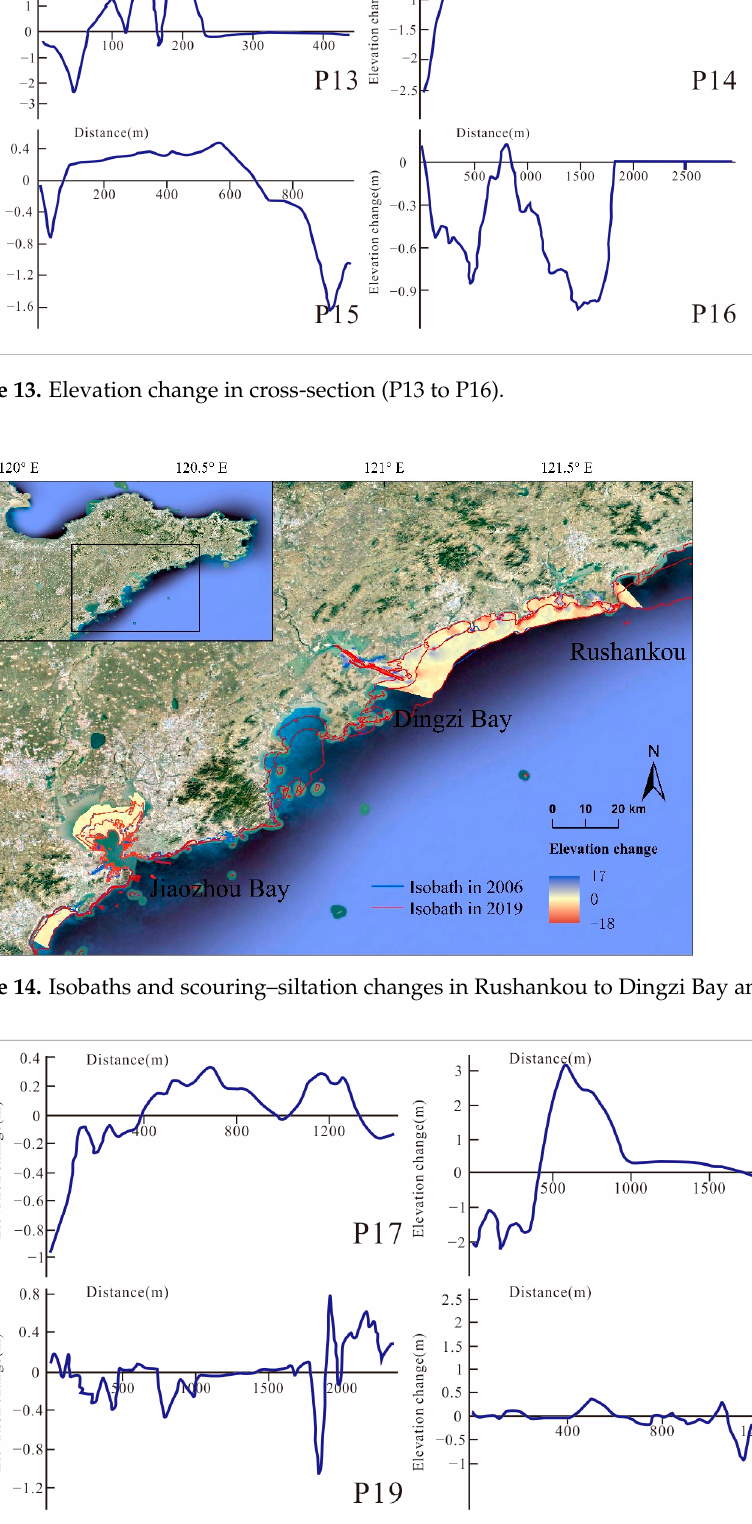
Figure 15. Elevation change in cross-section (P17 to P20).